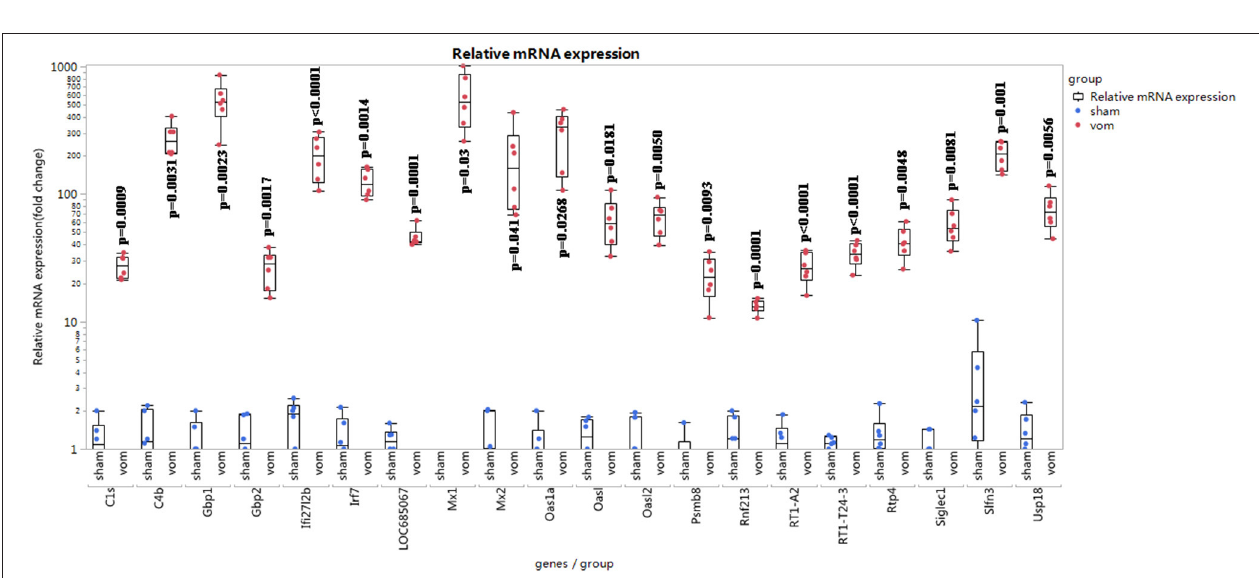
FIGURE 6 | Relative mRNA expression of top 20 differentially expressed genes in the RNA-seq data. The relative fold change was calculated using the 11 CT method (19). One sample in the sham group was set as “1”; the other samples referred to the sample. lack of neonatal RV VO models (10, 17, 18). The current study introduced a neonatal rat RV VO model to study pediatric RV VO, which may narrow down the translational gap from bench to bedside.